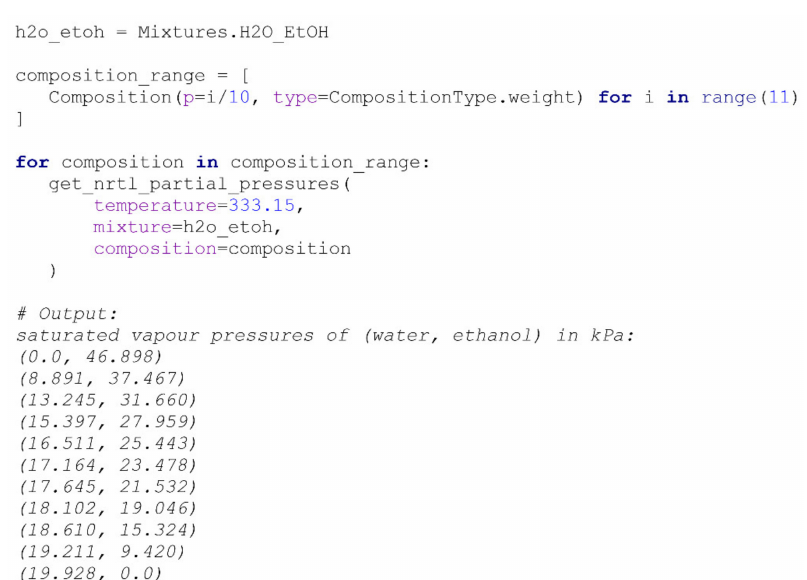
Scheme 2. Creation of a Mixture object and calculation of the saturated vapour pressure of the components at 333.15 ◦ K under a stated composition